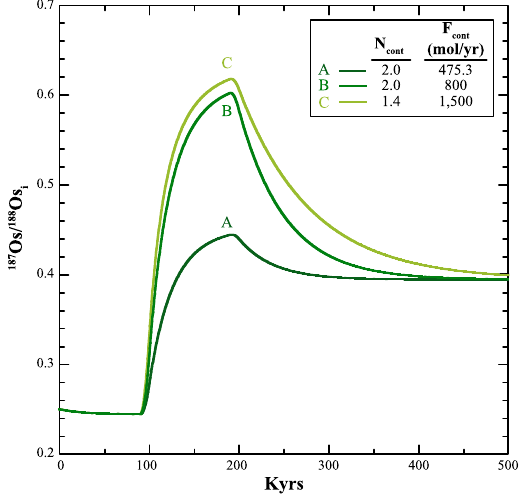
Figure 4. Examples of the modelled osmium isotopic composition of the ocean over the T-OAE. ( A ) For this model run, the osmium isotopic composition of the continental input was increased to 2.0 and the flux of osmium from continents was increased two-fold (475.3 mol/yr) during the Toarcian OAE. This resulted in the seawater osmium isotope values to increase to 0.44, which does not reproduce the observed osmium isotope excursion observed at East Tributary. ( B ) Model run where the osmium isotopic composition and flux of the continental input of osmium was increased to 2.0 by ~3.4x respectively. This model run reproduced the osmium isotope excursion. ( C ) The osmium isotope composition of the continental input of osmium was kept at 1.4 during the Toarcian OAE, but the flux of osmium from continents was increased by ~6.3x to reproduce the osmium isotope